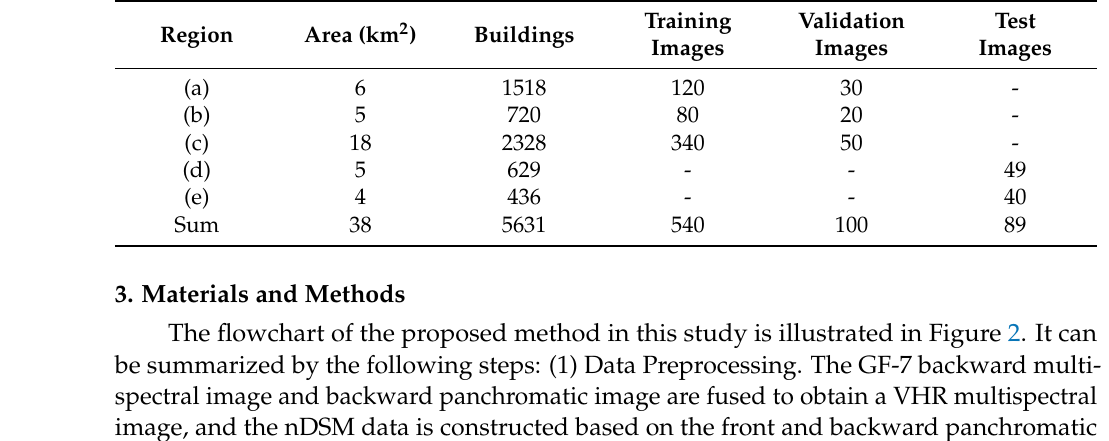
Table 1. GF-7 Self-Annotated Building